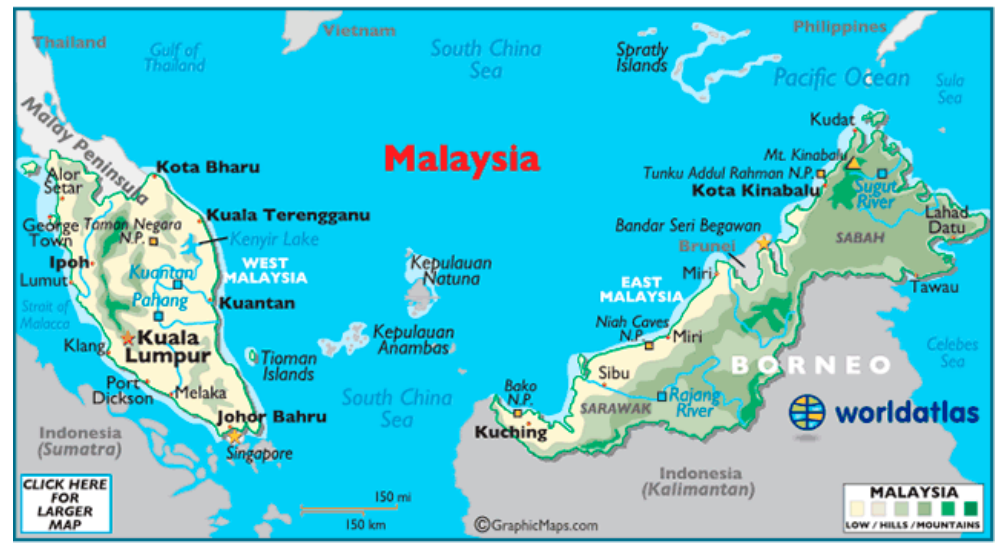
Figure 1. Location of Kuala Lumpur. Source: World Atlas Travel.